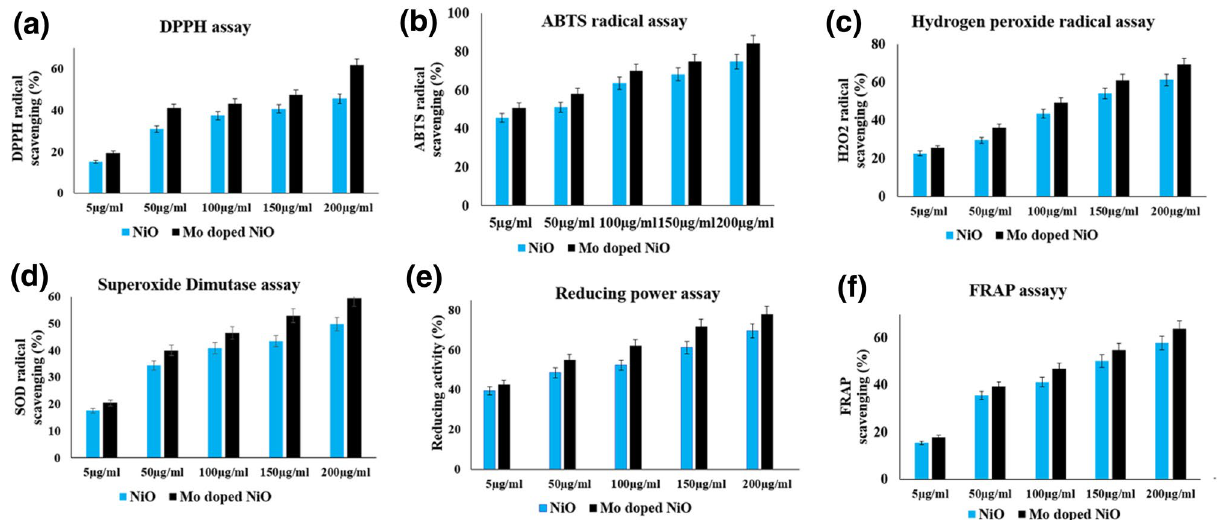
Figure 7. Antioxidant activity of NiO NPs and Mo doped NiO NPs on scavenging the free radicals via biochemical assays of ( a ) DPPH assay,( b ) ABTS radical assay, ( c ) H 2 O 2 radical assay, ( d ) SOD assay, ( e ) reducing power assay, and ( f ) FRAP